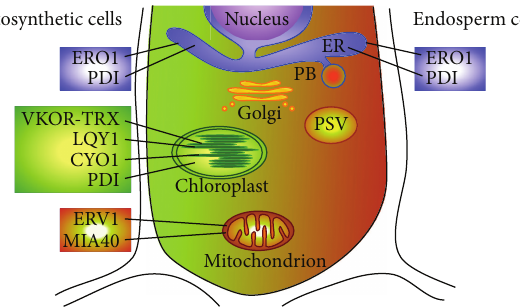
Figure 2: Overview of the sites of oxidative protein folding in photosynthetic and endosperm cells of plants. Disulfide-generating enzymes and disulfide carrier proteins characterized to date and their subcellular localizations are shown in photosynthetic (left) and endosperm (right) cells of plants. ER, endoplasmic reticulum; PB, protein body; PSV, protein storage